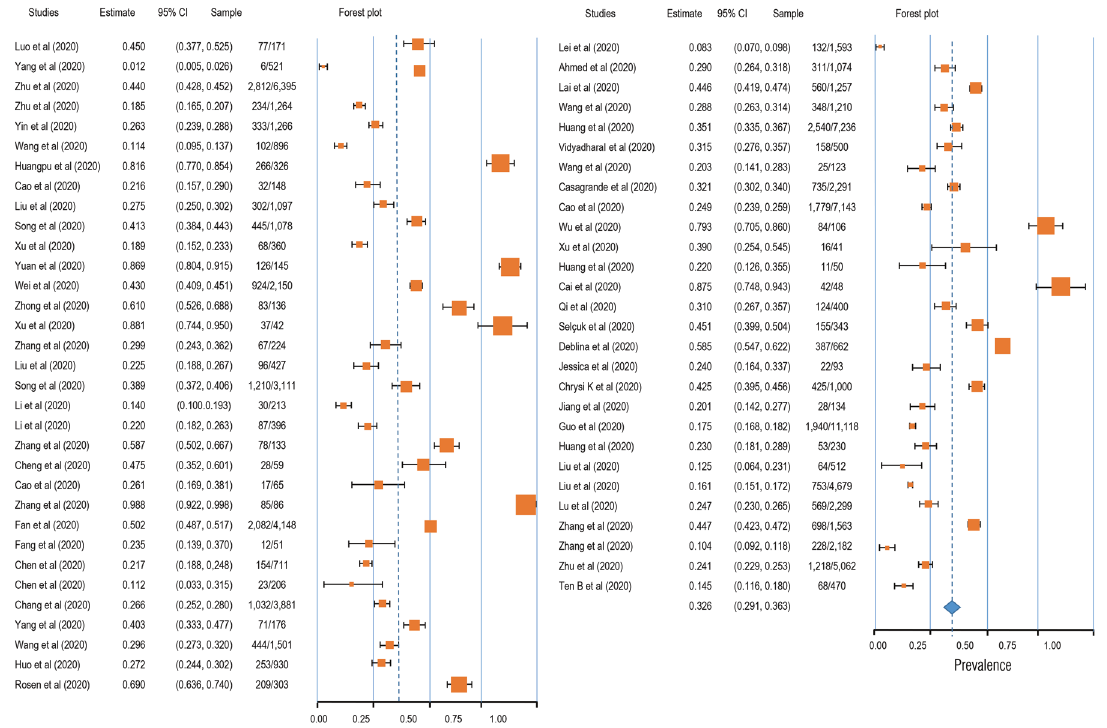
Fig. 2 Forest plot for meta-analytic results of the prevalence of anxiety symptoms. The squares colored by orange represent the point estimation foreffect towards corresponding study, with the large square size for high effect size. The orange diamond represent meta-analytic effect